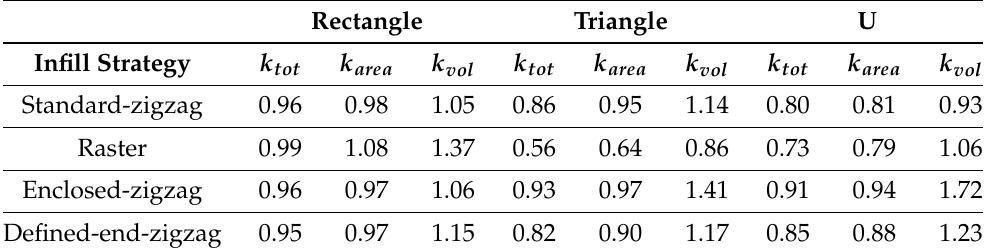
Figure 13. Coverage analysis of exemplary infill strategies of a 80 × 120 mm rectangle: path width, 10 mm; grid spacing, 0.2 mm; light blue, cavity; pink, material outside of the intended slice; green, one material layer; yellow, two material layers; red, three material layers; purple, four or more material layers. Table 2. k tot , k area and k vol for all infill strategies and test slices for d path =